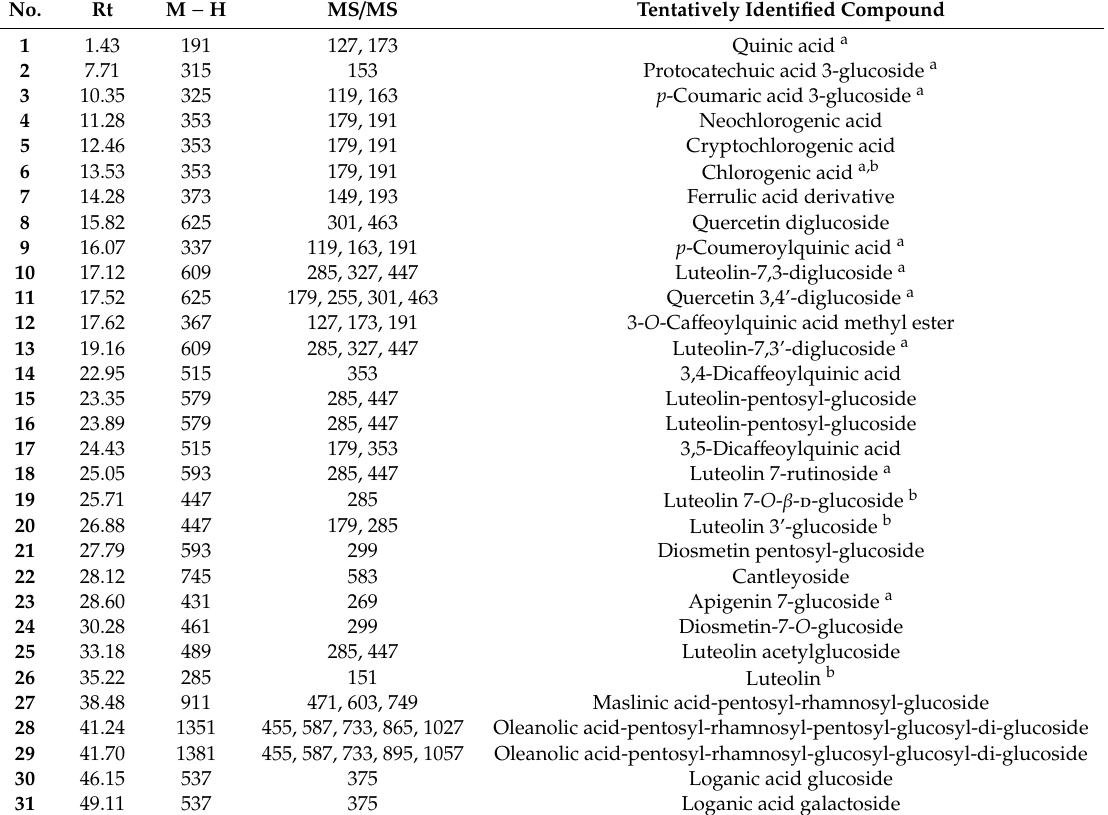
Table 1. Polyphenolics in a methanol extract of S. atropurpurea